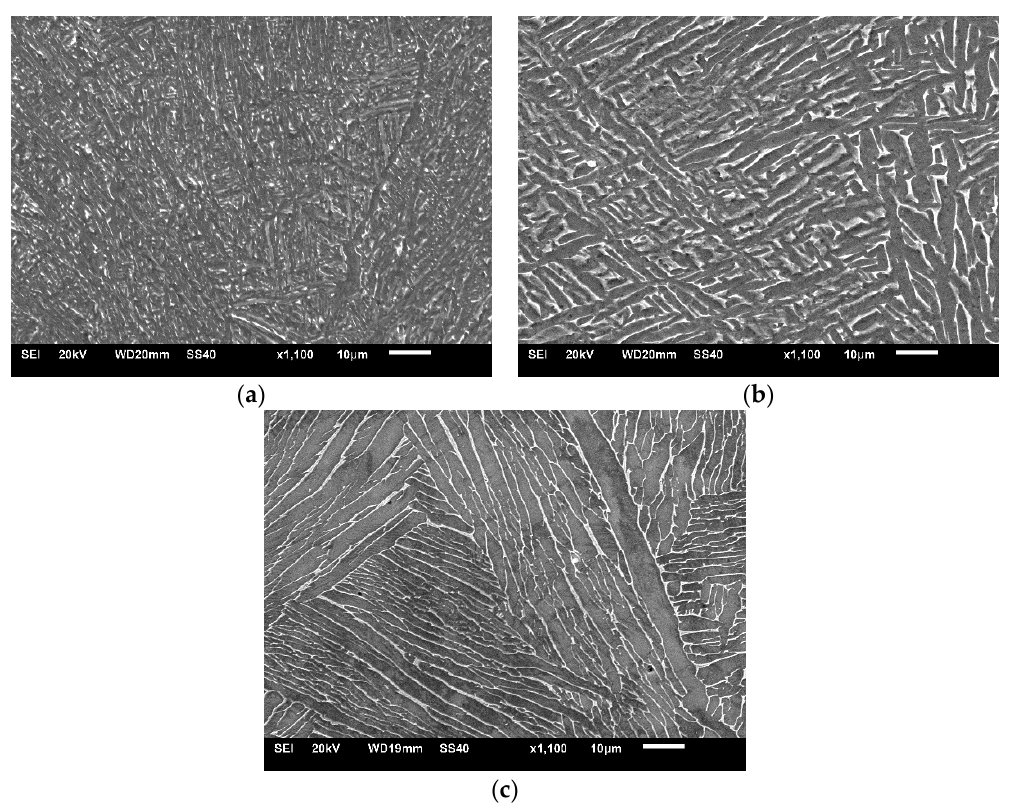
Figure 2. Secondary electron images (SEI) of heat-treated samples ( a ) C, ( b ) D, and ( c ) E of DMLS Ti6Al4V(ELI).